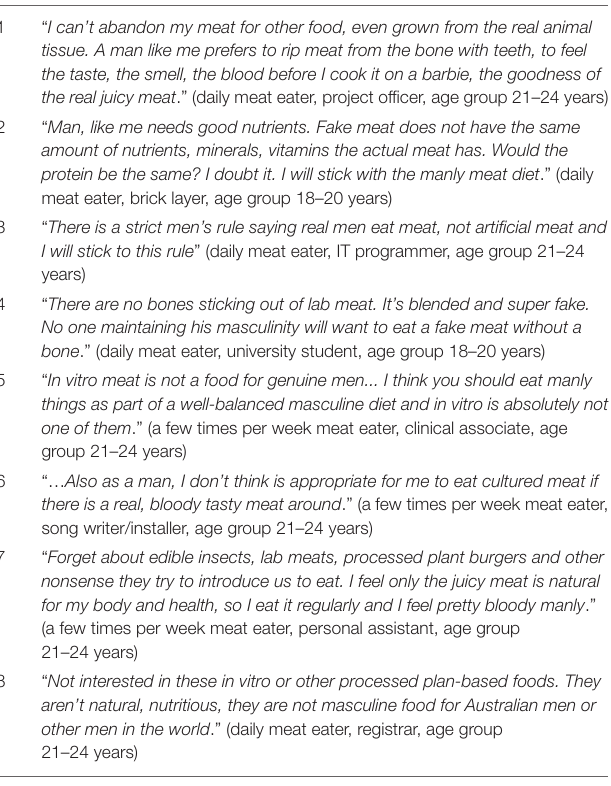
TABLE 5 | Sydney Gen Z’s environmental concerns related to meat. TABLE 6 | Sydney Gen Z’s perceptions of masculinity related to